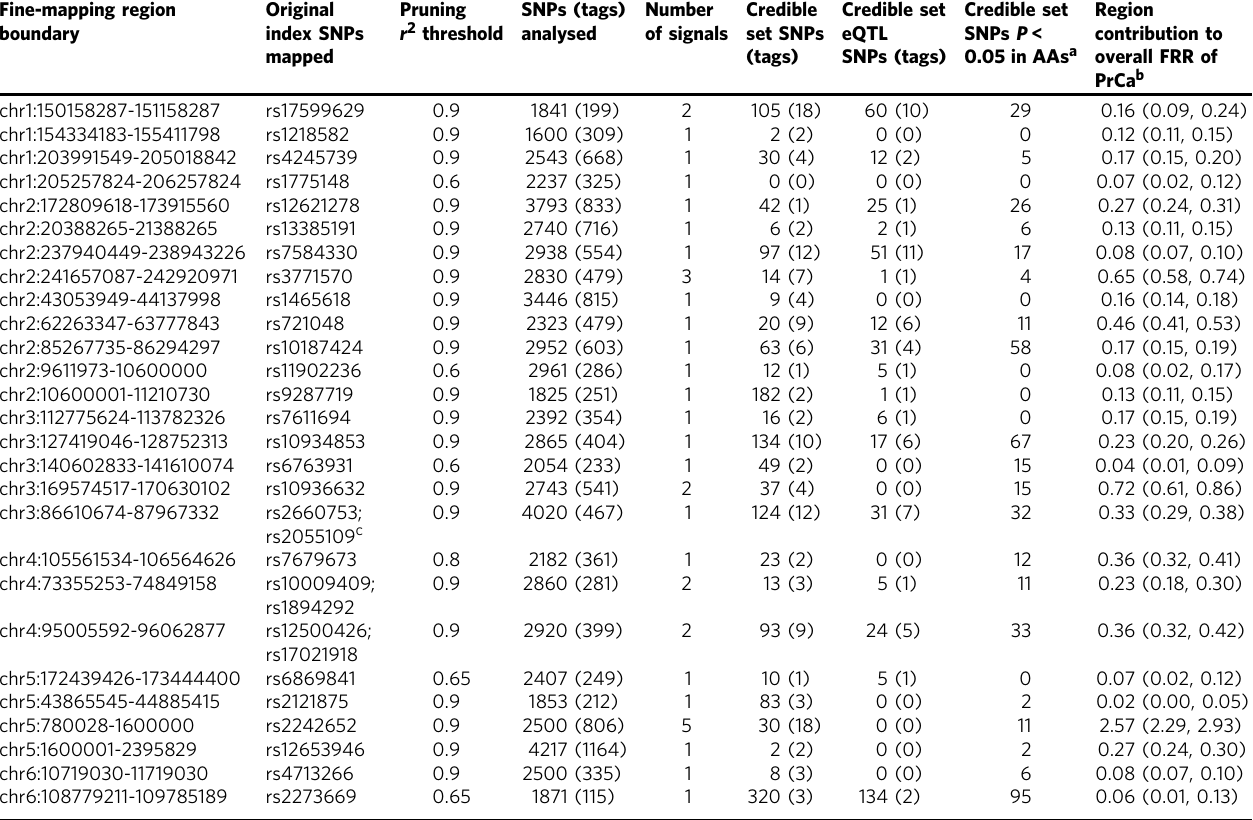
Table 1 Overview of fi ne-mapping results by region for regions 1 – 27 of the 80 regions fi ne-mapped Fine-mapping region